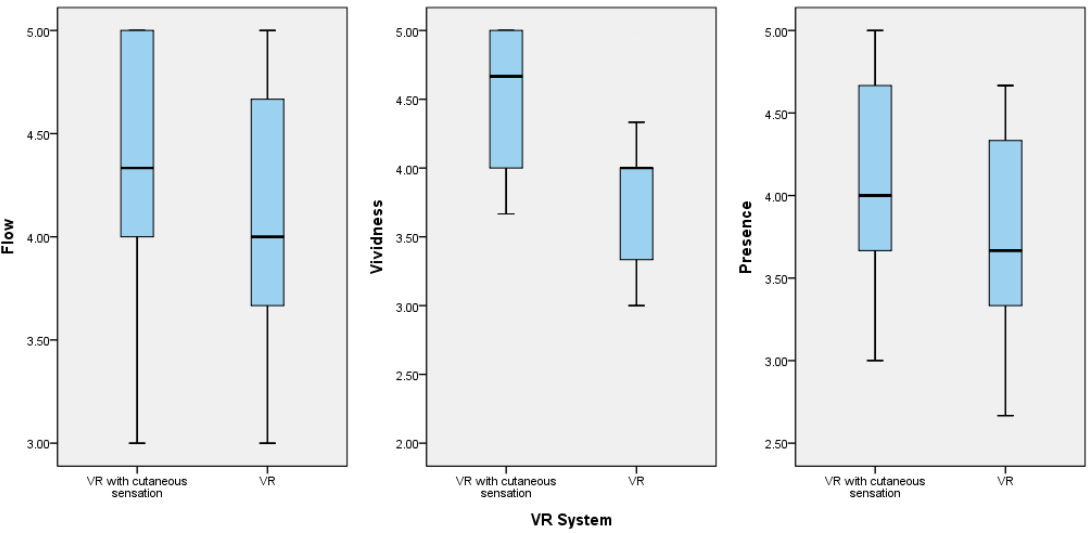
Figure 4. Comparison of the boxplots for the flow, vividness, and presence variables of the group of study participants who played the fire safety education VR game with cutaneous sensation and the group that played the basic fire safety education VR game.